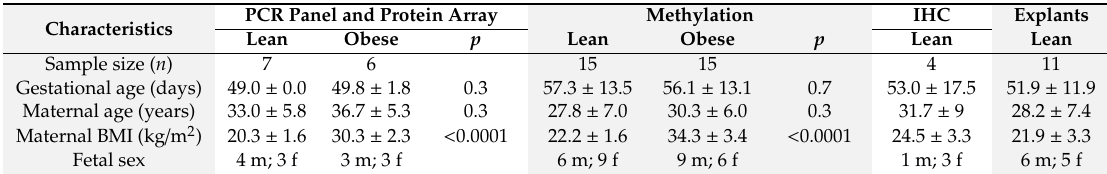
Table 1. Description of the study cohorts by experiment.